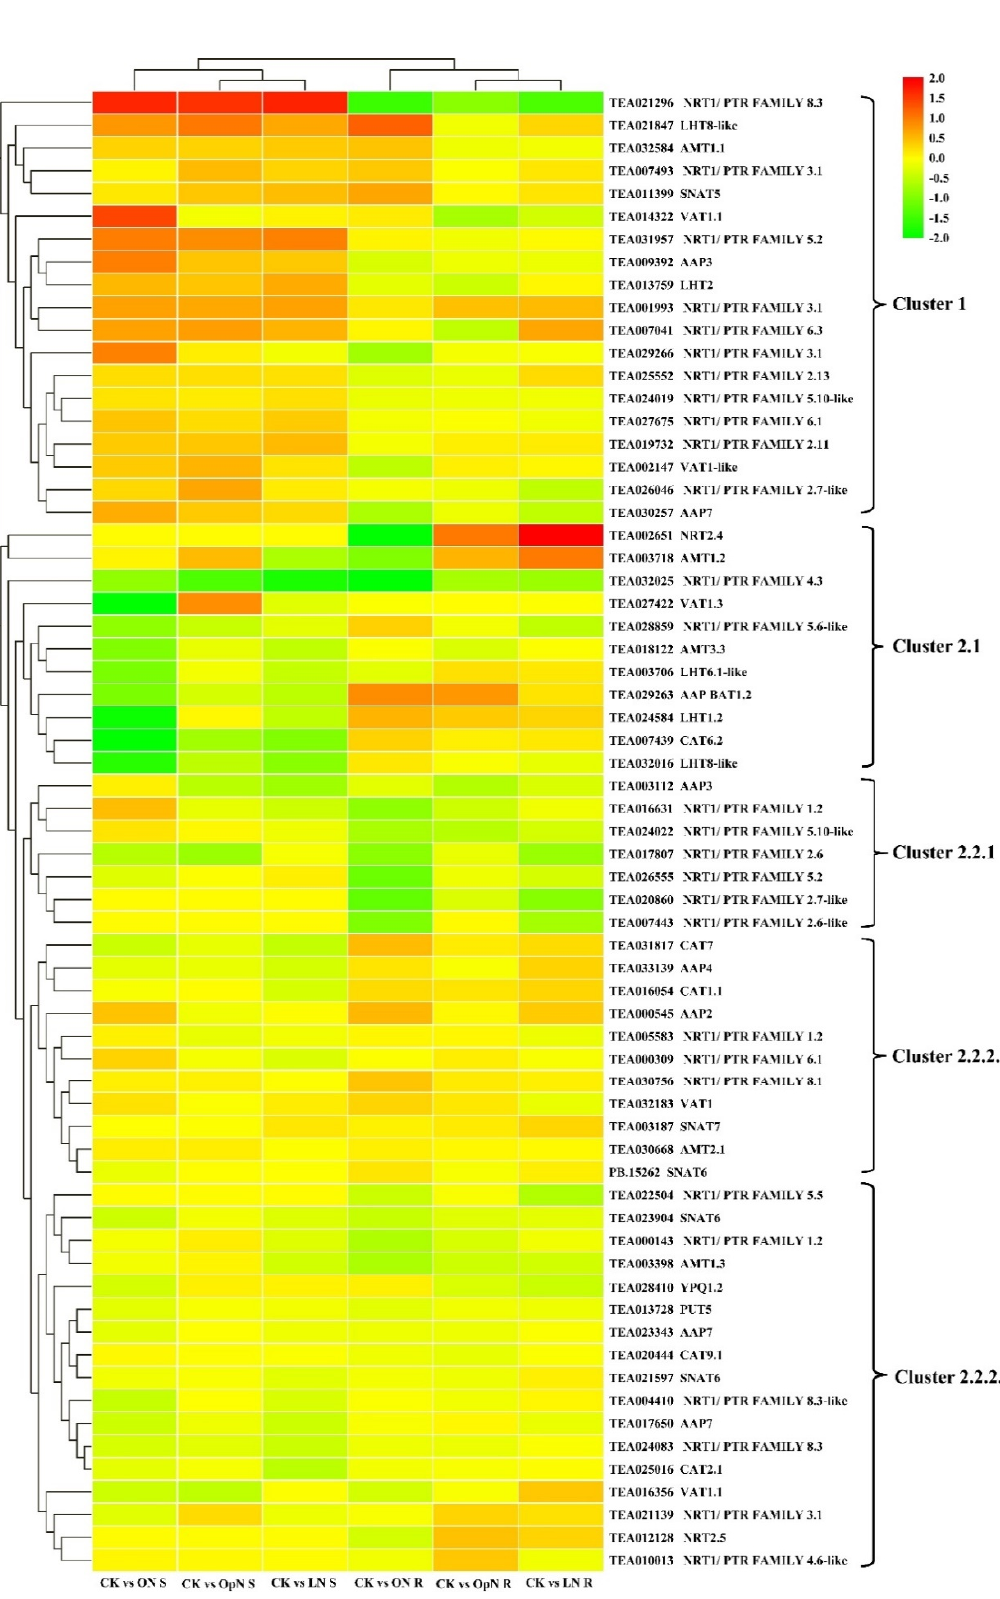
Figure 3. Heat map showing the relative expression of genes involved in N-uptake in roots and N-translocation within tea plant upon the various N treatments, compared with the control. The vertical bar indicates the relative expression ratio, and red, yellow, and green represent transcriptional up-regulation, no change, and down-regulation, respectively.